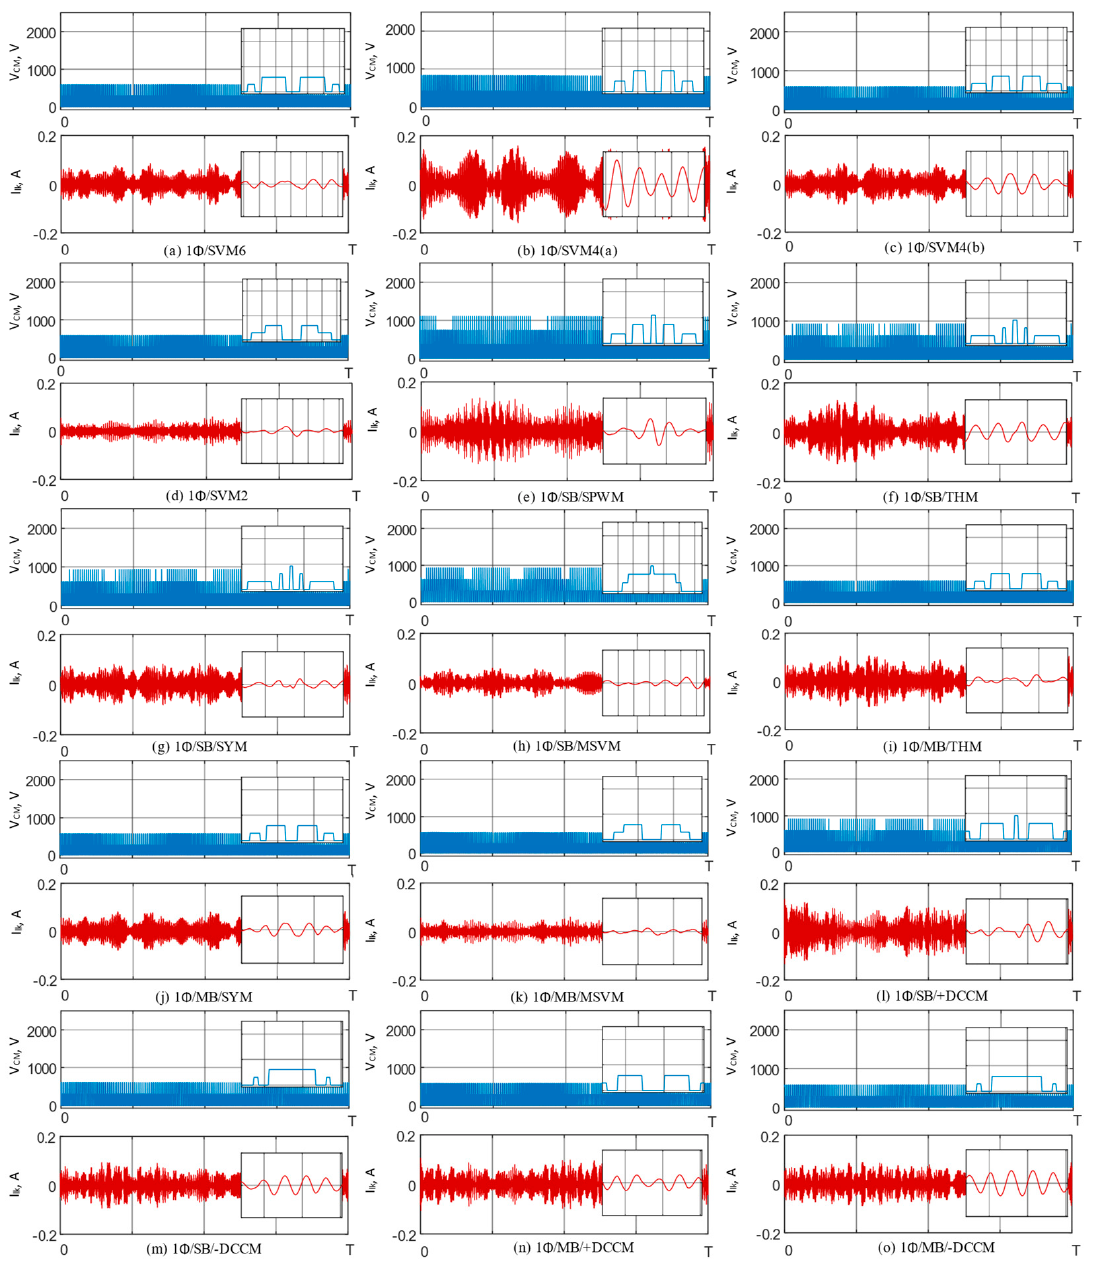
Figure 12. CMV and leakage current waveforms at Vph = 220 V for 1 ф ST schemes.